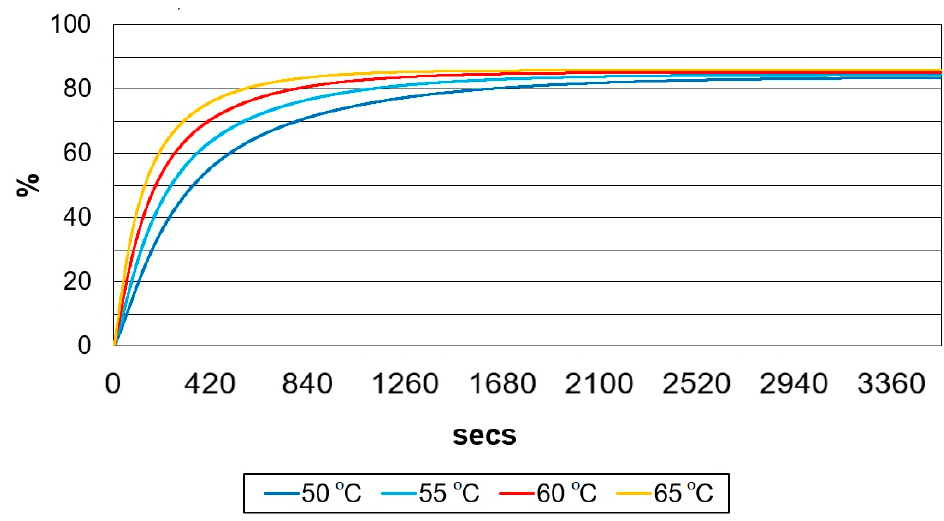
Figure 7. Conversion of methyl esters at different temperatures and 6:1 molar ratio.